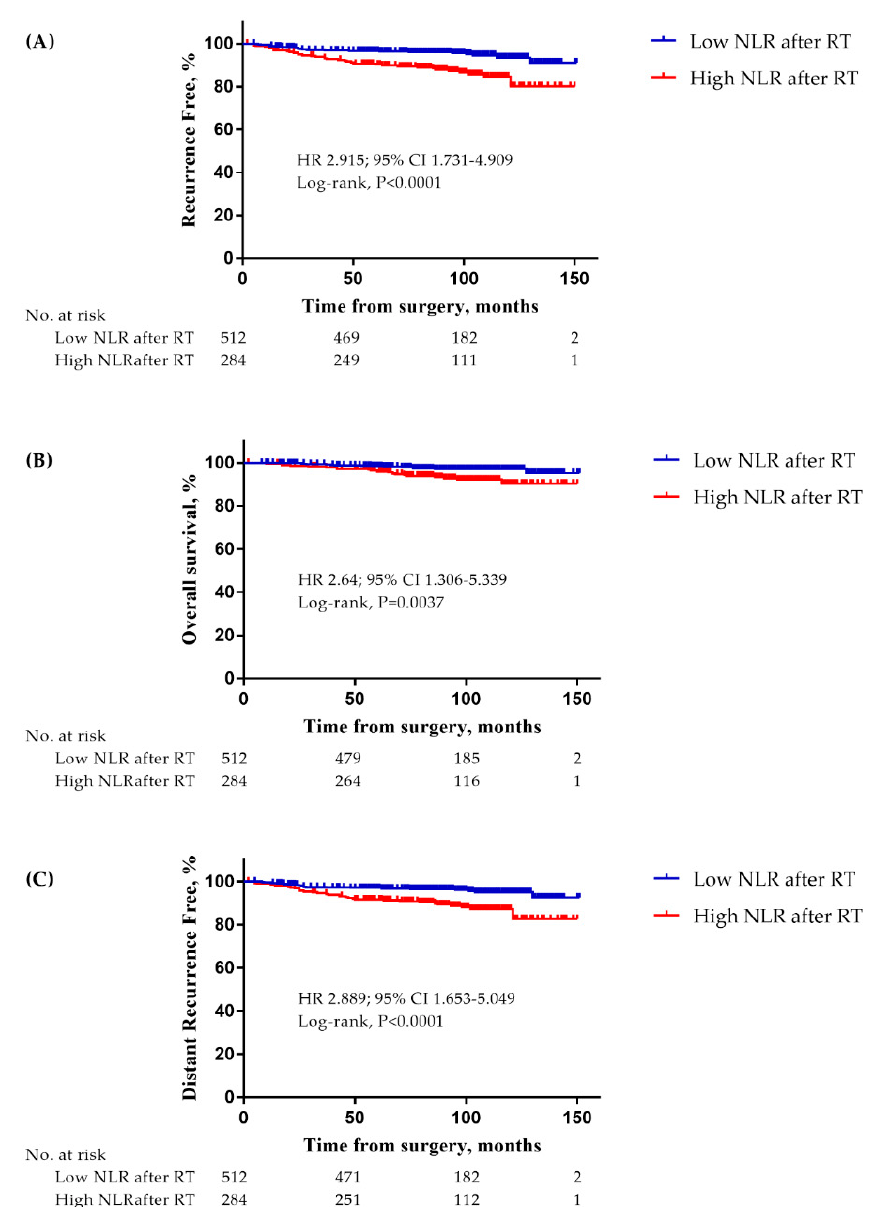
Figure 2. Kaplan-Meier survival curves of ( A ) RFS, ( B ) overall survival(OS), and ( C ) distant metastasis free survival (DMFS) based on high NLR after RT. ( A ) patients with high NLR after RT showed a lower RFS (HR 2.915; 95% CI 1.731–4.909, p < 0.0001), ( B ) patients with high NLR after RT showed a lower OS (HR 2.64; 95% CI 1.306–5.339, p = 0.0037), and ( C ) patients with high NLR after RT showed a lower DMFS (HR 2.889; 95% CI 1.653–5.049, p <